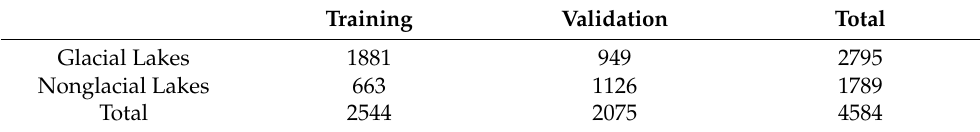
Table 3. Number of glacial and nonglacial lakes in the study area used for training and validation.